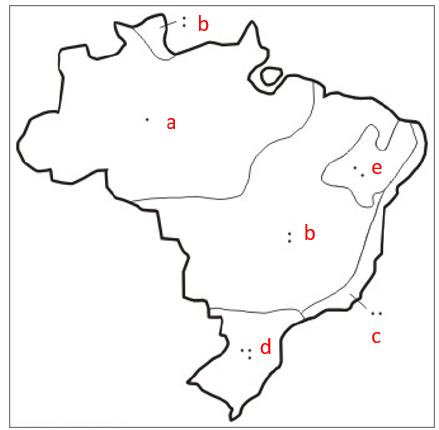
Figure 10. Tactile maps of Brazilian Climates produced by thermoform. Map A with textures and Map B with